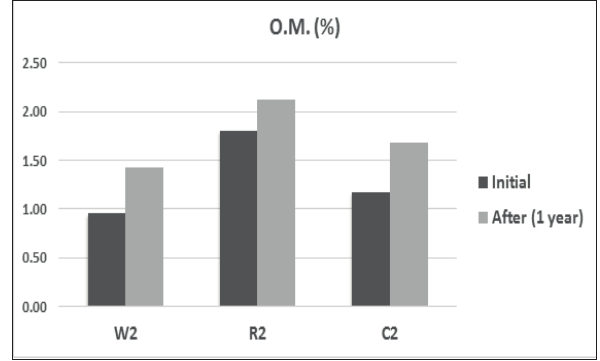
Figure 11. Soil organic matter content after eight months of cover crops establishment and trees planted in three farmers sites in Santo Tomas, Yurimaguas.